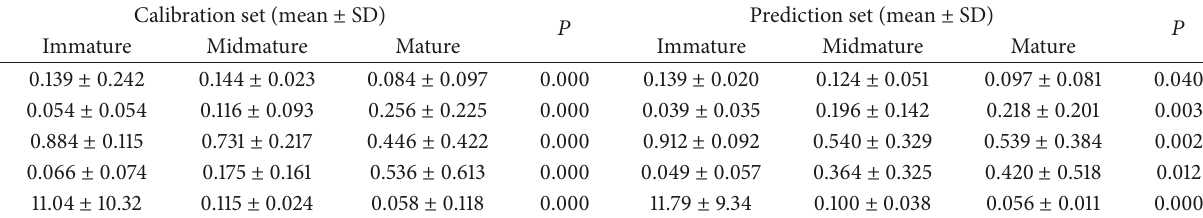
Table 2: The statistical analysis of the five indexes.